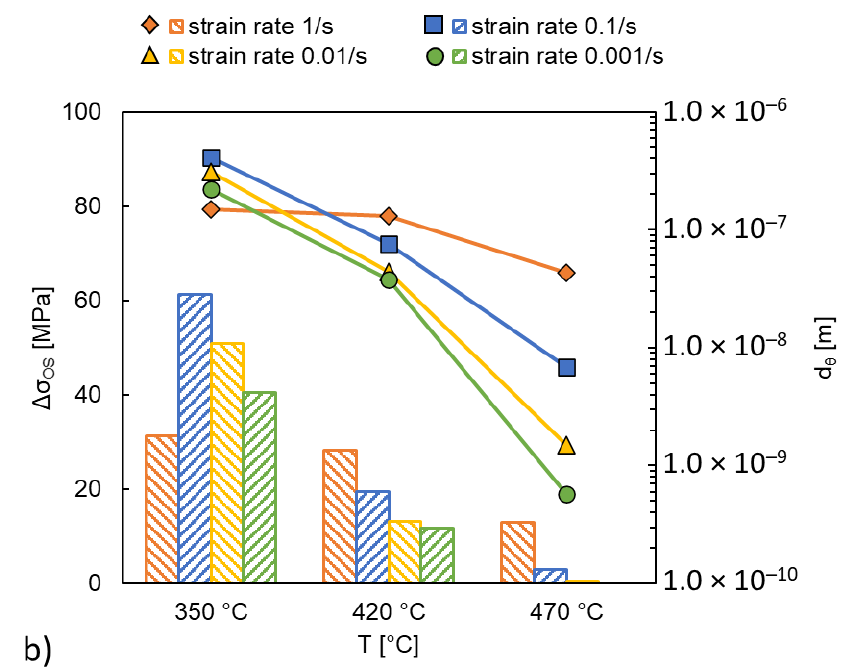
Figure 5. ( a ) The comparison between experimental data and calculated values with Δσ LB and Δσ MM for materials C0_50 and C1_23; ( b ) fitted Feret diameter d θ of θ -Al 2 Cu particles and the resulting Orowan strength contribution Δσ OS